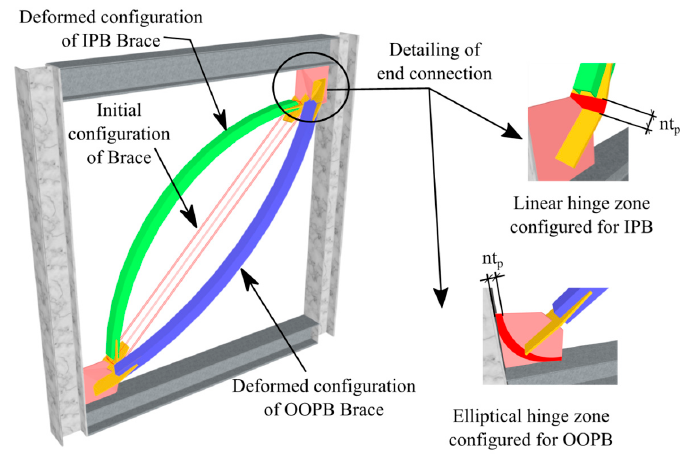
Figure 5. Illustration of plane of buckling and detailing of end connection including hinge zone. (t kp —thickness of knife plate, t gp —thickness of gusset plate, n—any rational number).